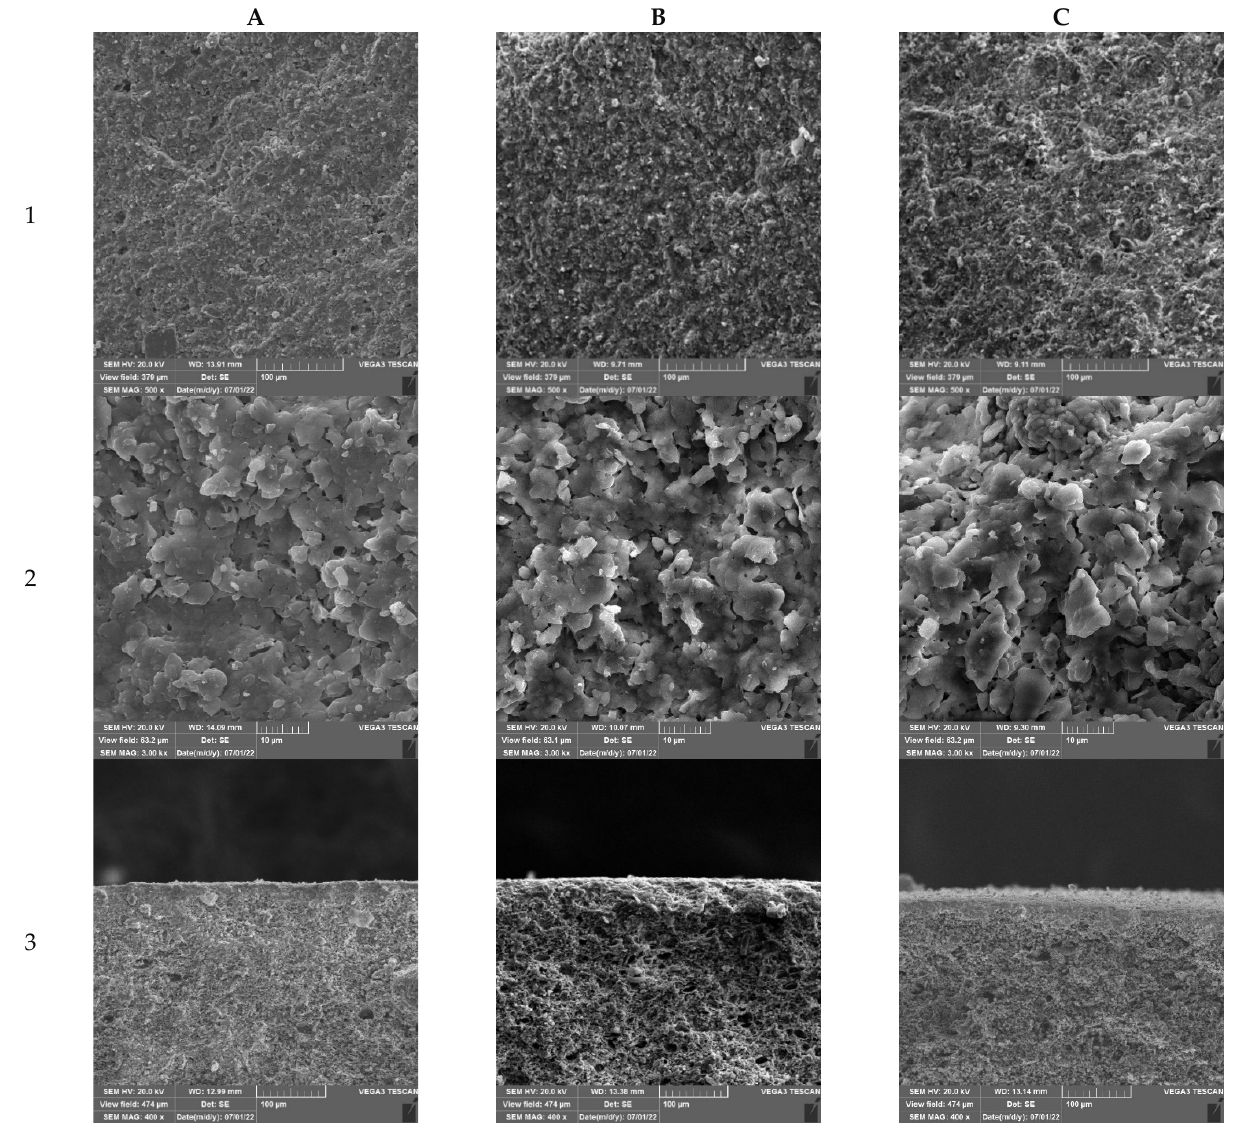
Figure 4. FESEM images of ceramic membranes M ( A ), M/SiC ( B ), and M/SiC/Fe20 ( C ).